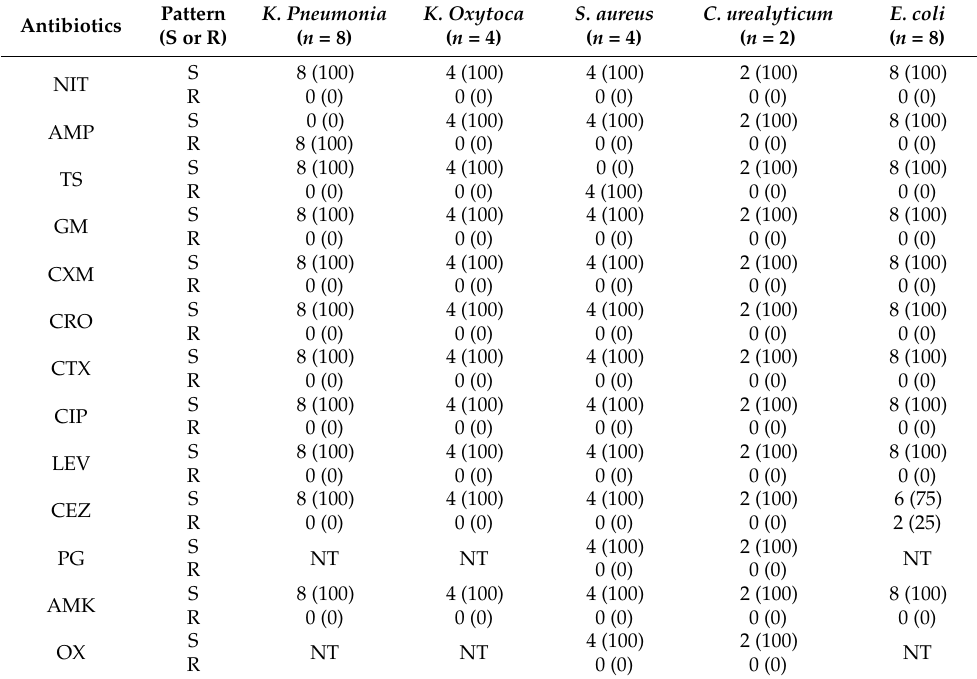
Table 4. In vitro antimicrobial susceptibility pattern of the bacteria isolates for non-diabetic individuals. Pattern Antibiotics (S or R)